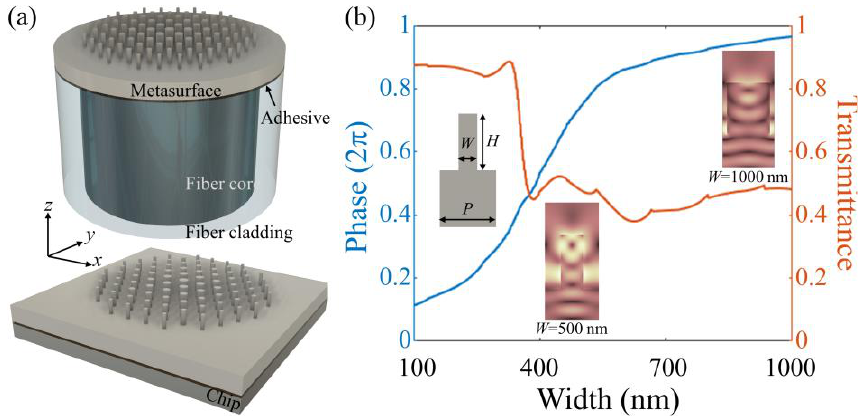
Figure 1. ( a ) Schematic of a monolithic dielectric metasurface on fiber (Top) and chip (Bottom) platform, respectively; ( b ) the phase delay and transmittance obtained via FDTD simulations of the LN nanopillar as a function of width W . The insets are the cell diagram and electric field profiles for W = 500 and 1000 nm from left to right, respectively.